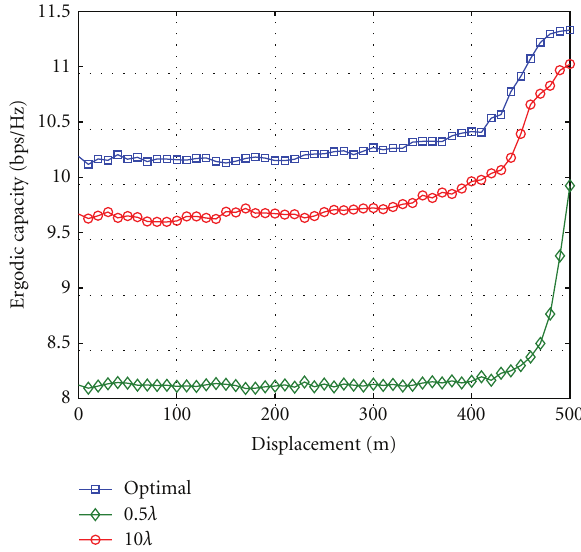
Figure 4: Ergodic capacity as a function of SNR for di ff erent antenna spacings ( K -factor = 9 dB, l = 275 m).